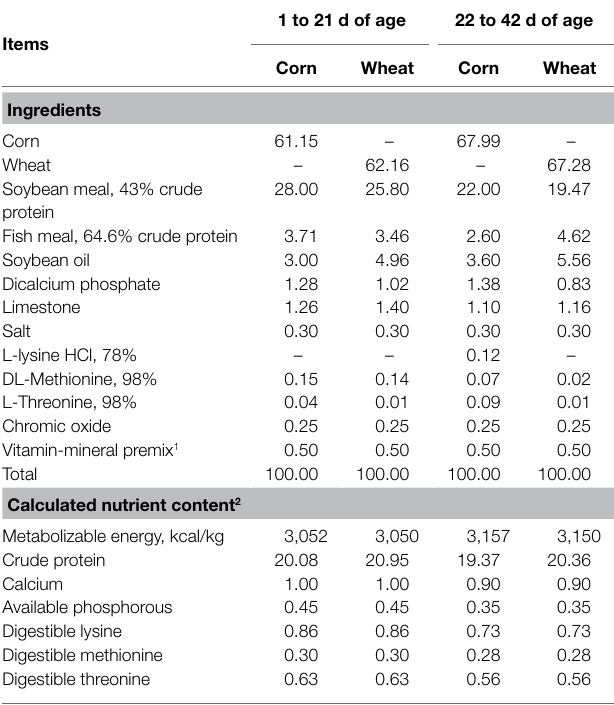
TABLE 1 | Composition and nutrient levels of basal diets (%, as fed basis).